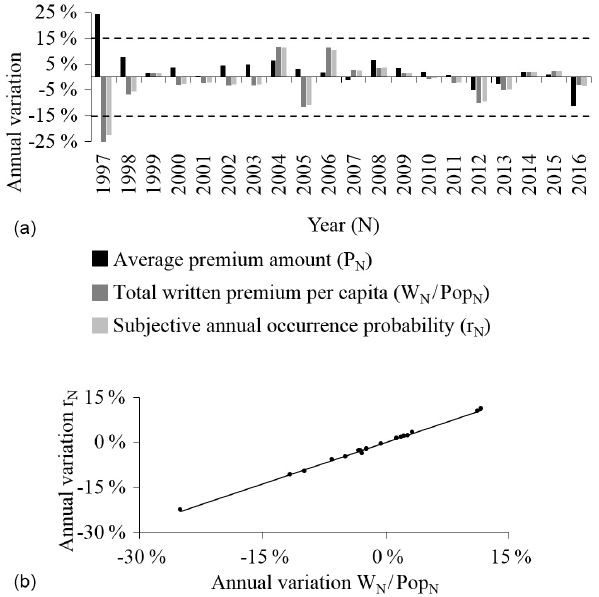
Figure 5. (a) Variations in the average premium amount, the total written premium per capita and the subjective annual occurrence probability between 1997 and 2016. Variations are calculated com- pared to the previous year. Dashed lines represent the thresholds for a significant variation. (b) Fit between the variation in the to- tal written premium per capita and the subjective annual occurrence probability.